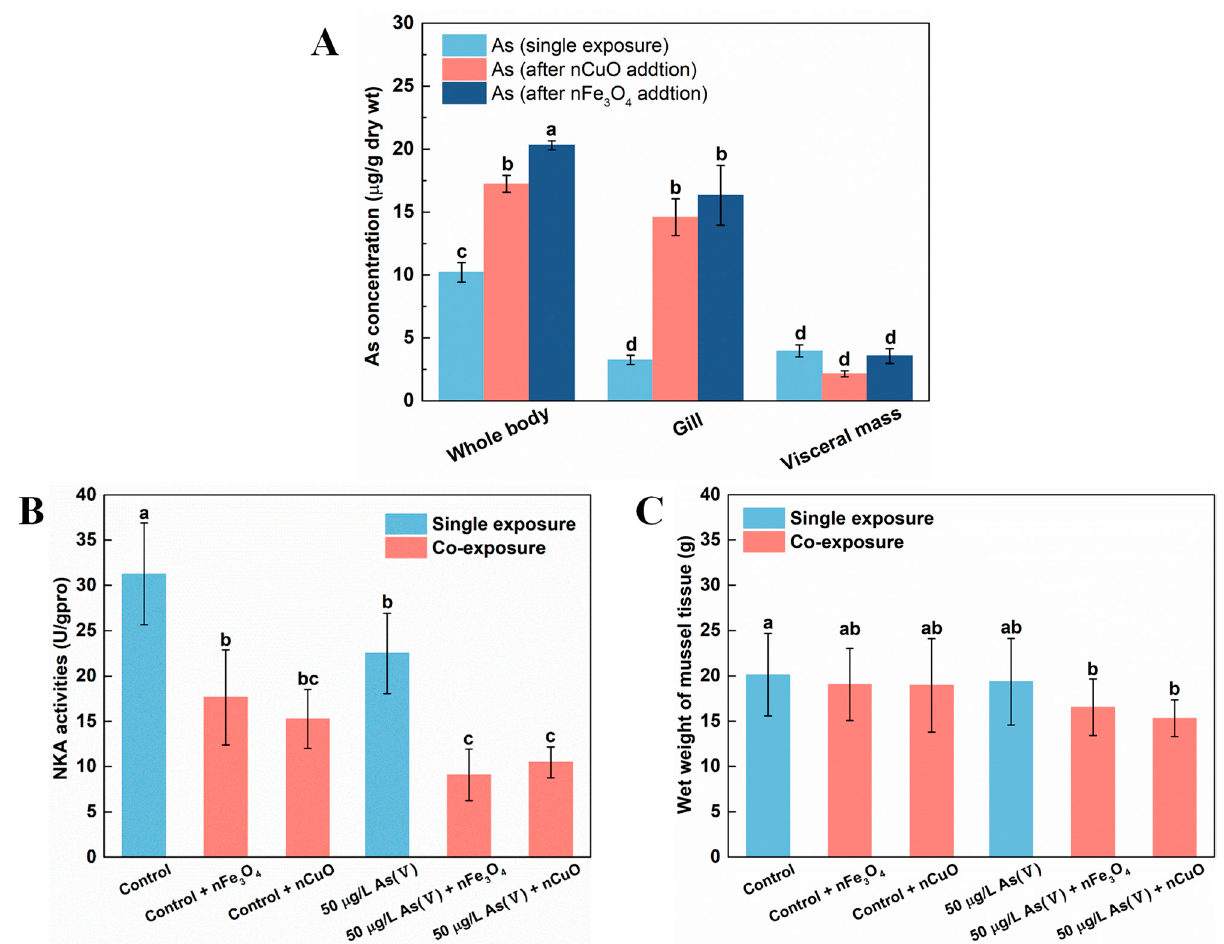
Figure 3. As Distribution before and after exposed to nFe 3 O 4 and nCuO in mussels ( A ). Na + -K + -ATPase (NKA) activities in mussels exposed to different treatments at the end of the exposure ( B ). Body weight of mussels at the end of single As(V) exposure and co-exposure ( C ). Values are the mean ± SD (n = 6). Significant differences ( p < 0.05) among exposure conditions were represented with different letters. Control: Mussels exposed to artificial seawater for 21 days (single exposure). Control + nCuO: Mussels exposed to 1 mg/L nCuO for 2 weeks after control exposure (co-exposure). Control + nFe 3 O 4 : Mussels exposed to 1 mg/L nFe 3 O 4 for 2 weeks after control exposure (co-exposure). 50 μ g/L As(V) only: Mussels were cultured in 50 μ g/L As(V) solution for 21 days (single exposure). 50 μ g/L As(V) + nCuO: Mussels exposed to 50 μ g/L As(V) + nCuO for 2 weeks after 50 μ g/L As(V) exposure (co-exposure). 50 μ g/L As(V) + nFe 3 O 4 : Mussels exposed to 50 μ g/L As(V) + nFe 3 O 4 for 2 weeks after 50 μ g/L As(V) exposure (co-exposure).